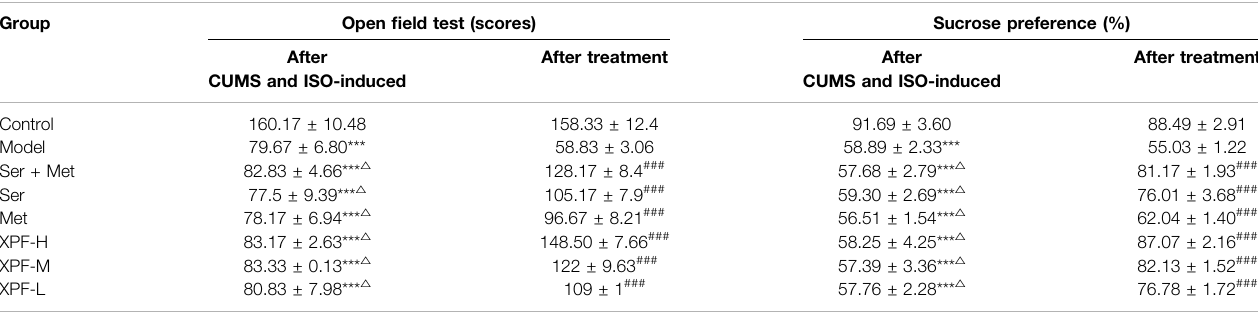
Values are expressed as the mean ± SD; n (cid:2) 6 – 8 in each group. Compared with controll group after CUMS and ISO-induced. *** P < 0.005. Compared with model group after CUMS and ISO-induced, △ P > 0.05. Compared with model group after treatment, ### P <